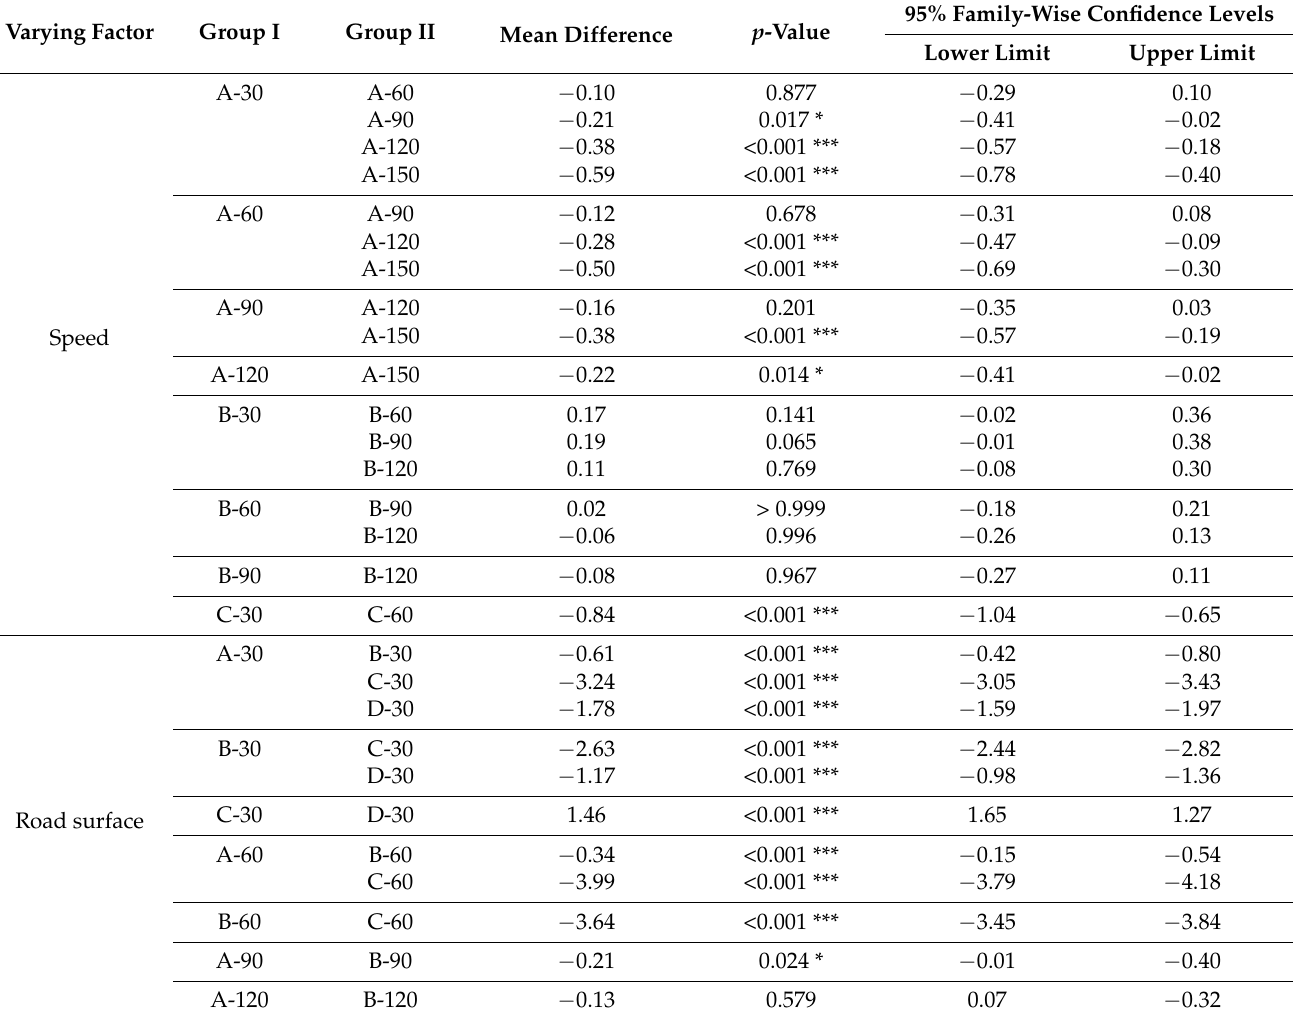
Table 4. Summarized results of the post hoc Tukey’s HSD test, comparing the mean Displacement Index D x depending on road surface and speed